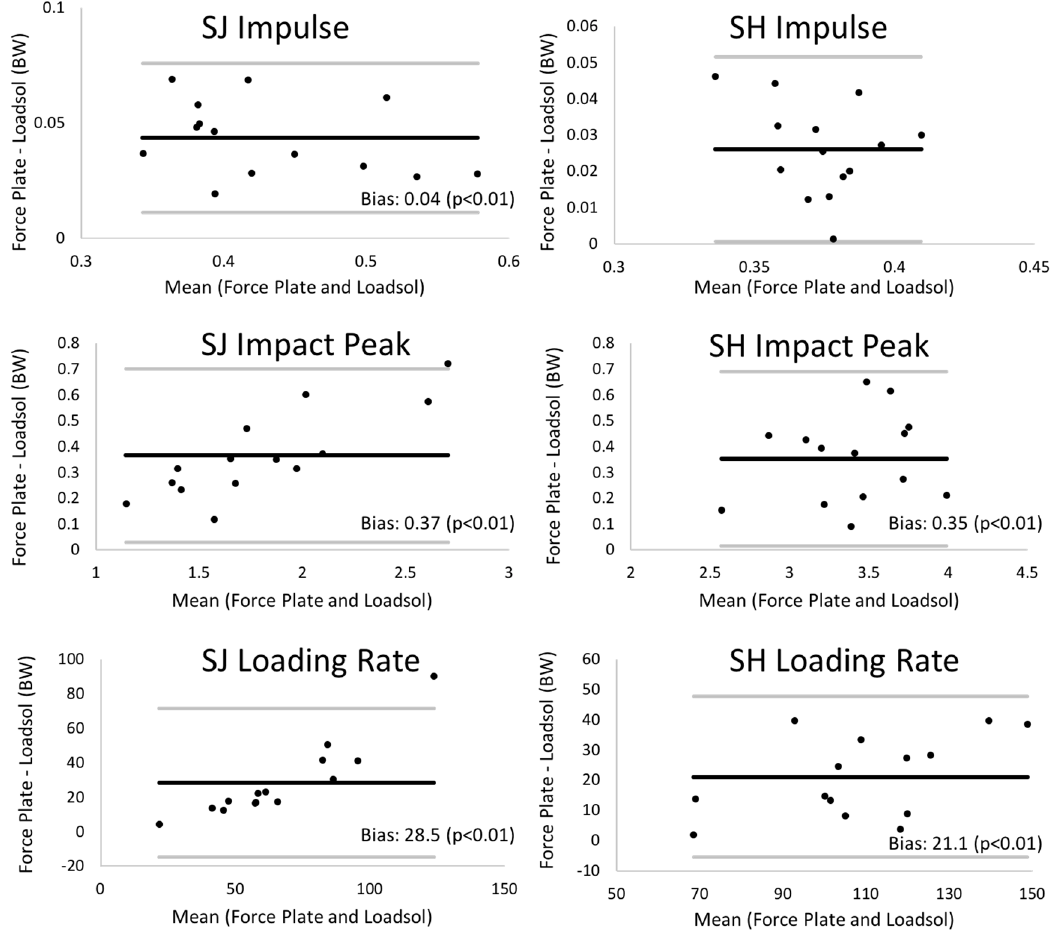
Figure 3. Bland–Altman plots showing the validity of the loadsol sensors at 200 Hz relative to the force plate. Note: on the plot, the bias (mean difference) and significance (paired t -test) of this bias are shown for each measure on both the stop jump (SJ) and single hop (SH) tasks. The bold black line on plots represents the mean bias, and the thin gray lines on plots are limits of agreement (mean bias ± 1.96 SD of bias).